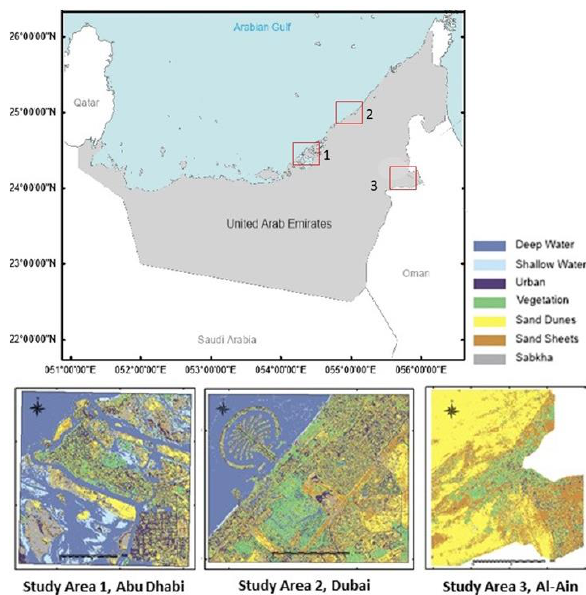
Figure 1 . The three study areas: Abu Dhabi, Dubai, and Al-Ain. The total area of study area-1 is 72,052.95 ha which covers the city of AD, the capital of the UAE. AD is located on a small desert island that jets into the Arabian Gulf and includes the AD island and outside the island (e.g. Maqta’, Mussafah, Lulu, and Al Reem). The LULC can be categorized into 4 main classes: water, vegetation, urban, and undeveloped areas classes. Water covers around 45.5% of study area-1 (~37% deep water and ~8.5% shallow water). Around 30% of the study area-1 is undeveloped areas (consists of sand dunes, sand sheets, and sabkhas). The urbanized areas cover around 14.5% and around 10% are covered by vegetation class. The summer season (April – September) temperature varies between 35° and 45°, with a climax of 48°C in July and August, accompanied by a high concentration of water vapor boosting the relative humidity to reach up to 90%. On the other hand, the winter season’s (October – March) temperatures range from 10 to 24°C. The humidity throughout all seasons is relatively higher in those areas near in Arabian Gulf. Rainfall occurs during the winter season mainly between November and February with precipitation amounts barely reaching 12 cm per year (National Center of Meteorology 1995 -2018). The mean annual rainfall can be highly variable between one year to another.